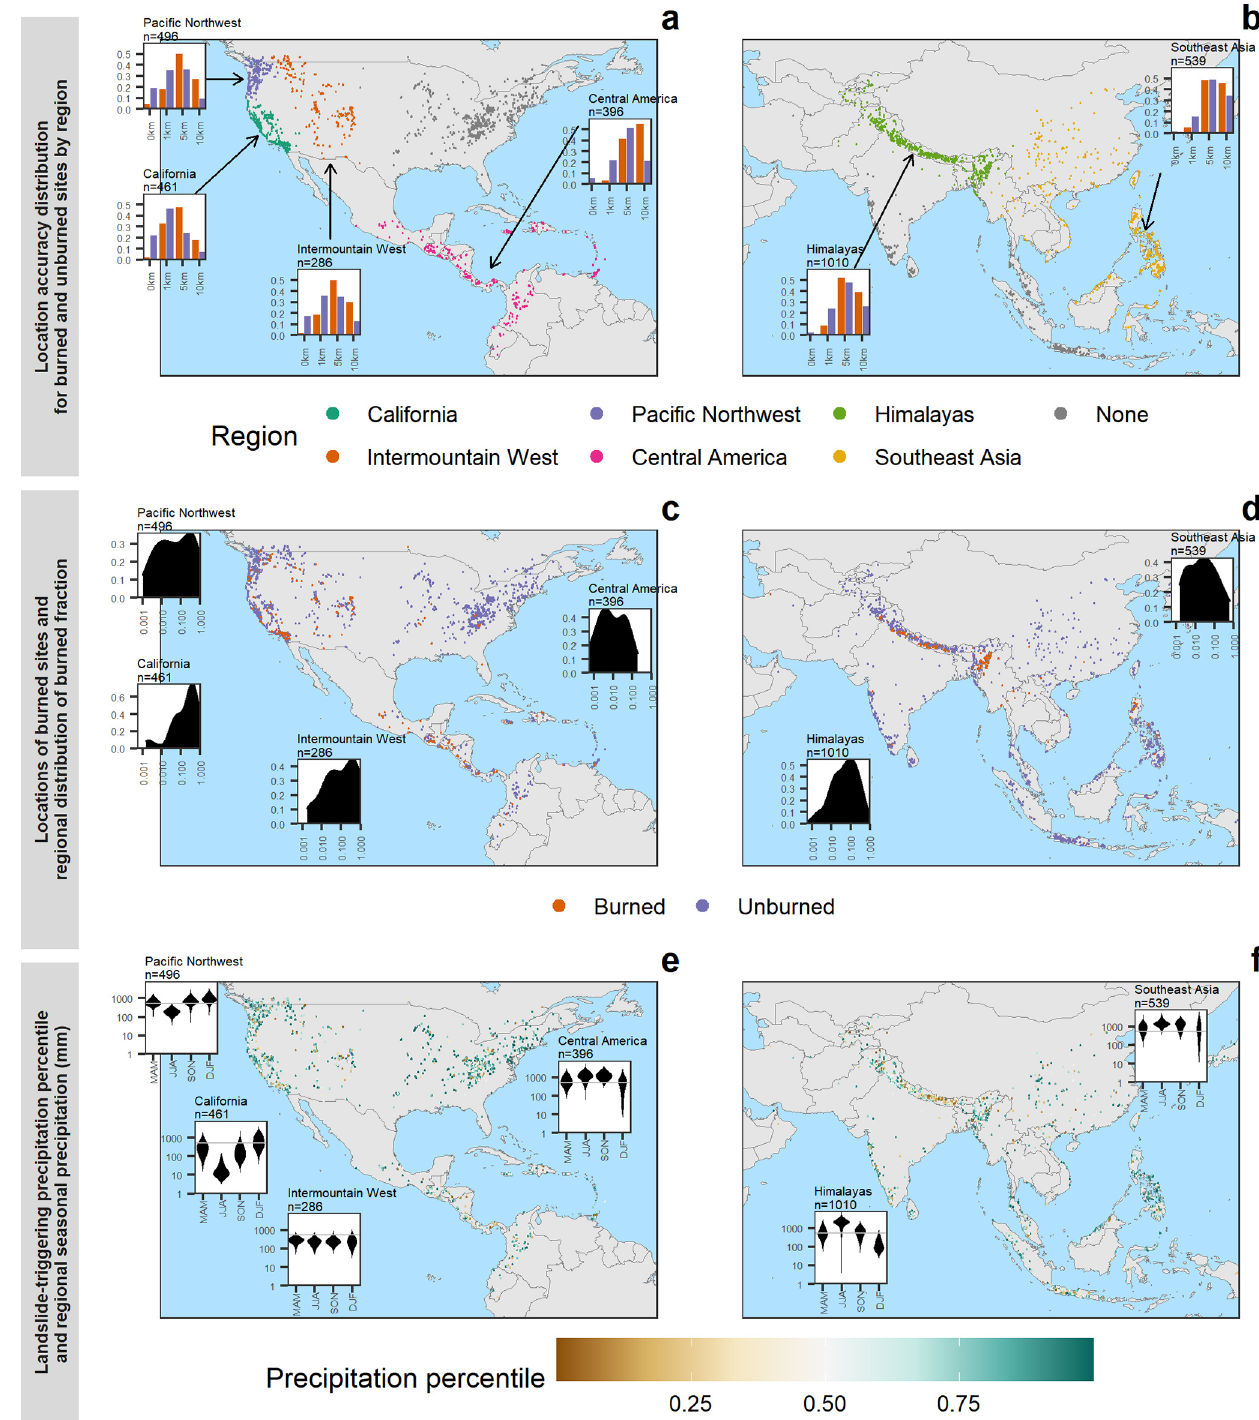
Figure 1. Landslide locations ( n = 5313, 2006–2017), showing region coding (see Sect. 2.2) in panels (a) and (b) , with location accuracy for burned and unburned groups in the regional insets; burned/unburned classification at the time of the mass movement in panels (c) and (d) , with regional insets showing kernel density portrayal of the fraction of burned area for the mass movement locations from the 3 years preceding the mass movement; and the precipitation percentile on the day of the mass movement in panels (e) and (f) , with regional insets of kernel density estimates (violin plots) of the climatological (1981–2020) seasonal precipitation magnitude (mm) including a reference line indicating the median seasonal average across all sites globally. Country boundaries were obtained from the maps R package (Deckmyn et al.,